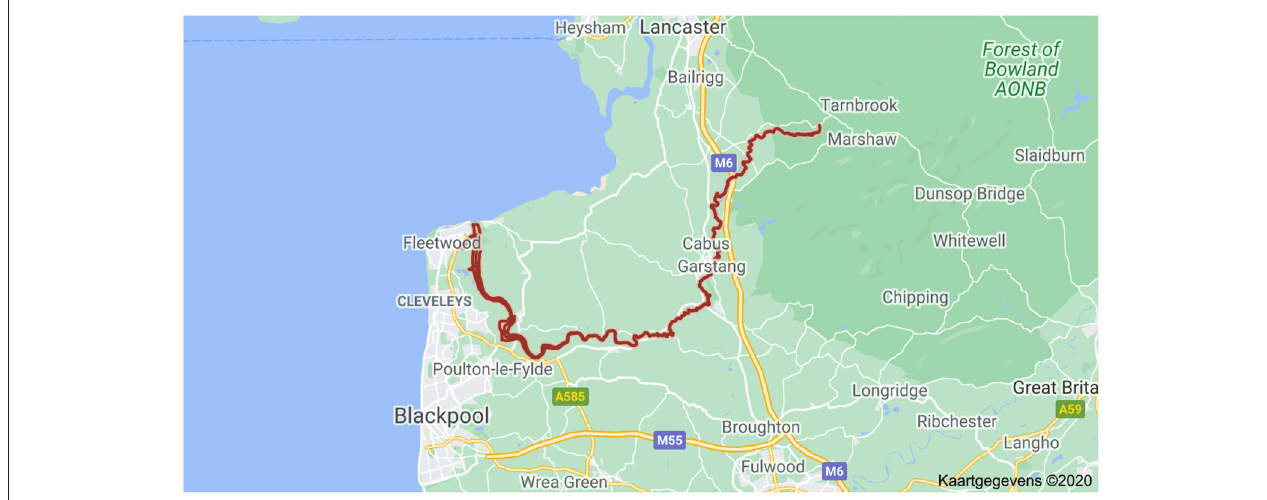
FIGURE 4 | Sampling station at Garstang in River Wyre, Lancaster, UK (Google